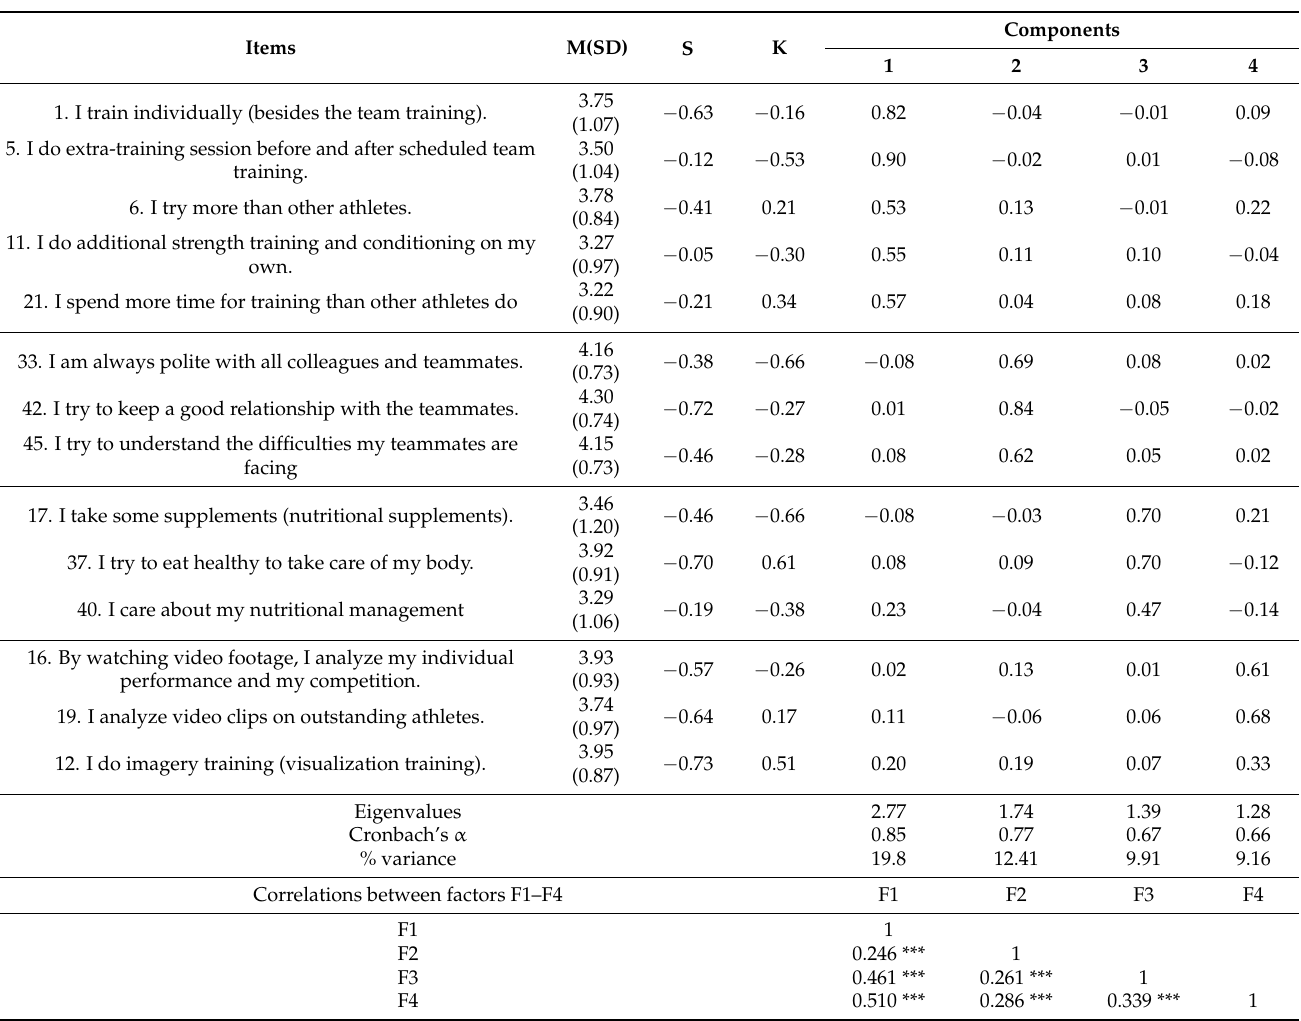
Table 1. The extracted factors from